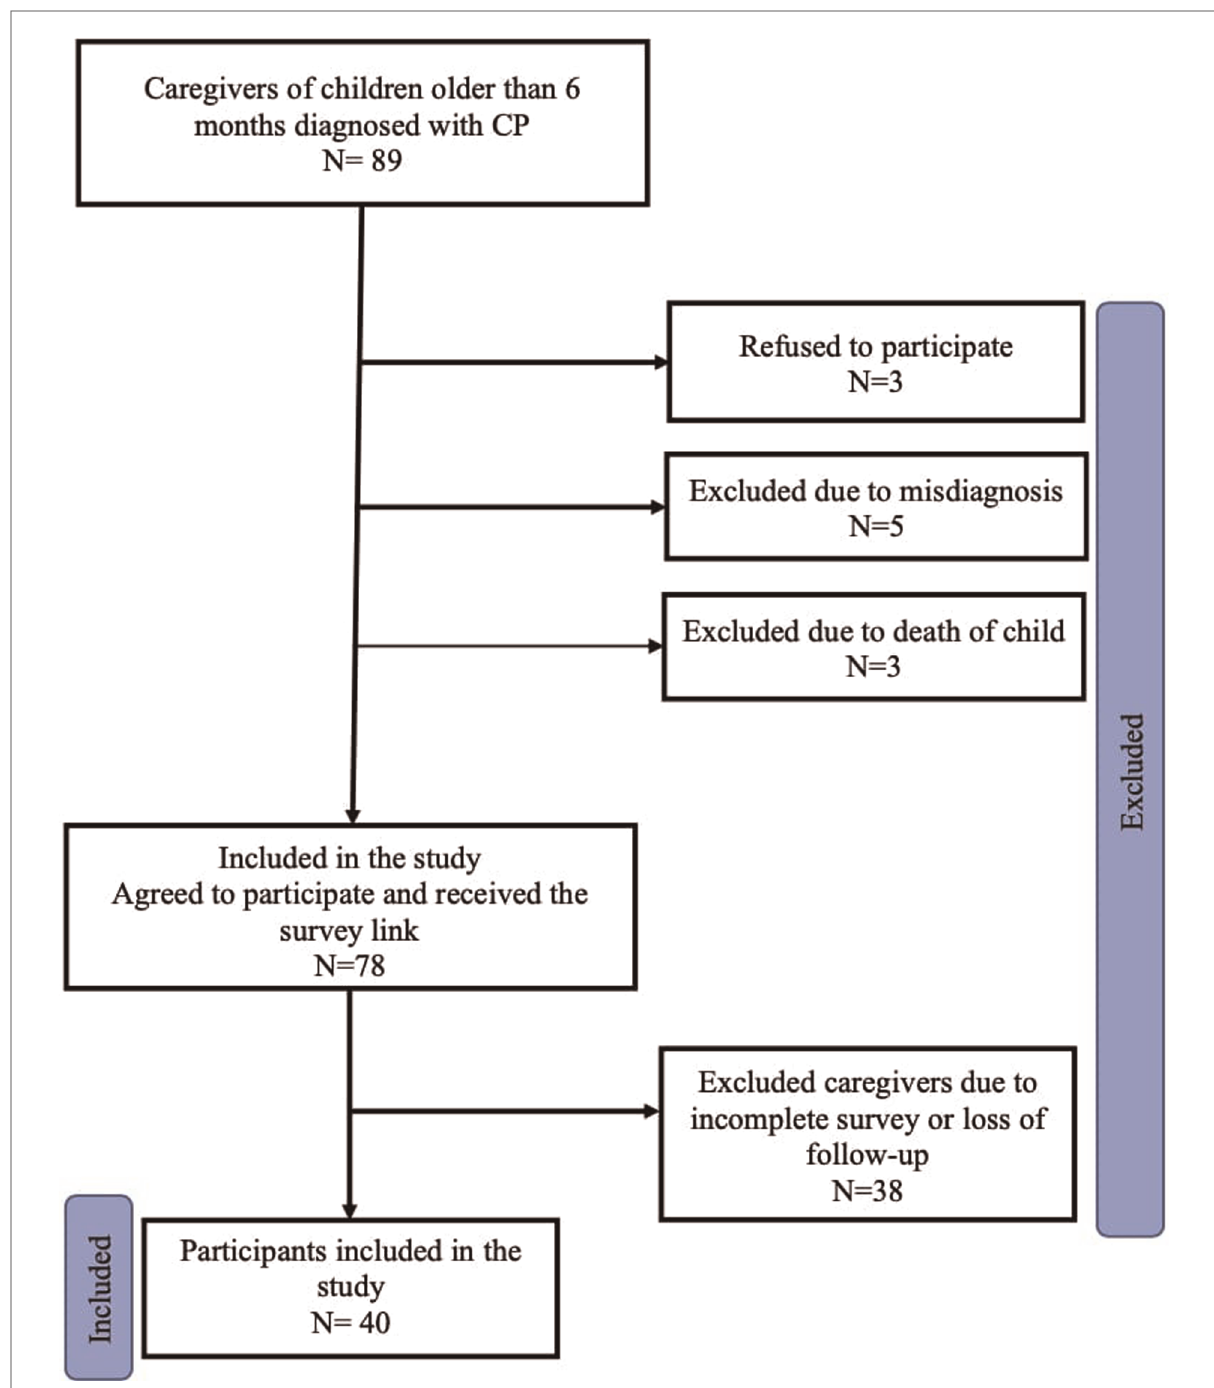
FIGURE 1 Flow chart showing the process of subjects selection. The initial sample number was 89 (Caregivers of children with CP). A total number of 75 caregivers agreed to participate in the study. However, only 40 caregivers completed the